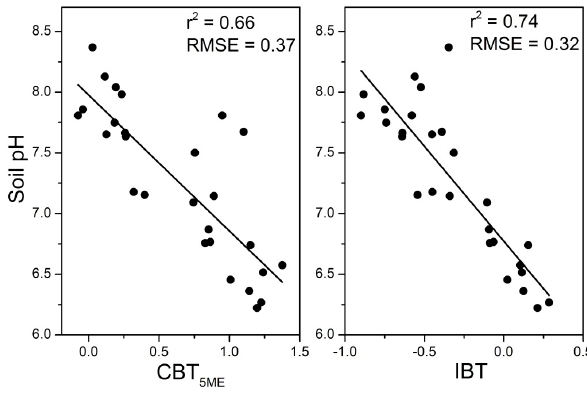
Figure 8. Plots of fractional abundance of 6-methyl brGDGTs in the total amount of brGDGTs ( f 6ME ) versus soil pH in the QTP.